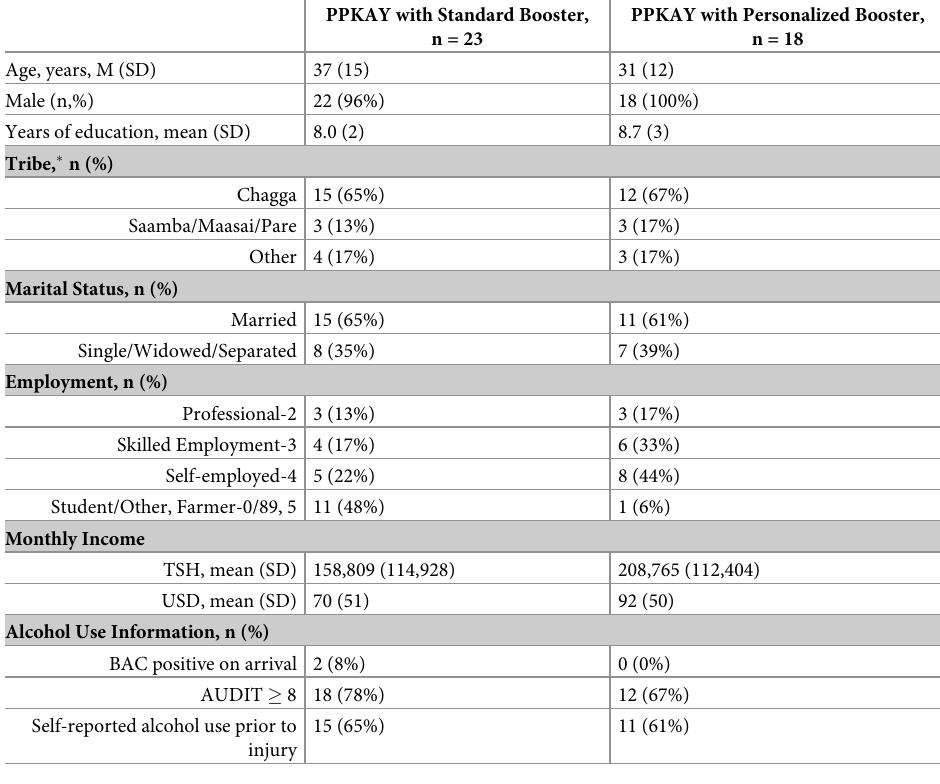
Table 2. Demographic information stratified by booster arm